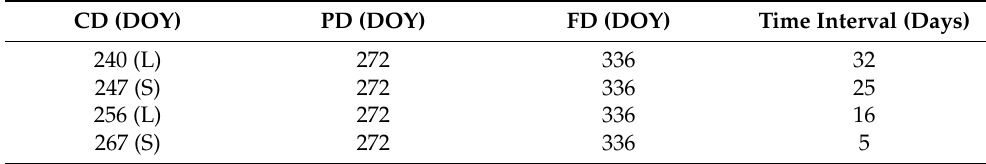
Table 2. Data selected for MNLC